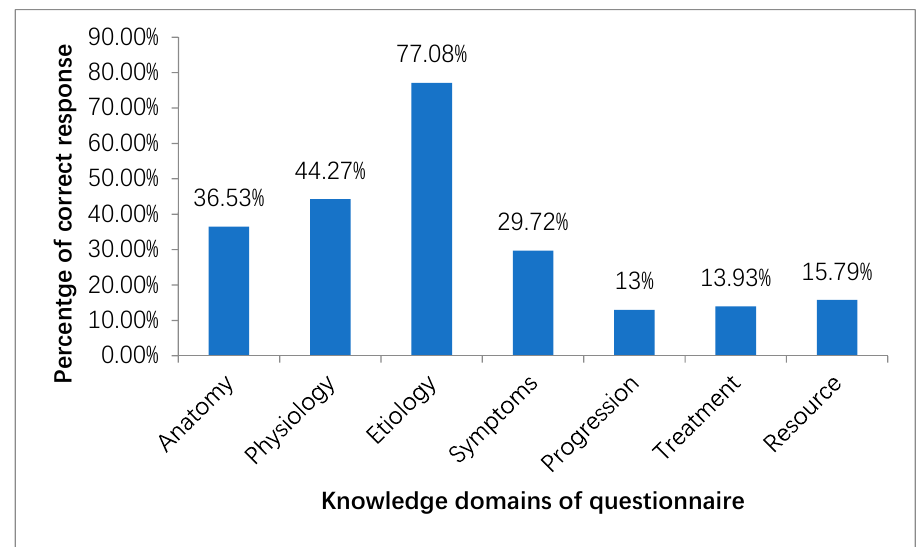
Figure 1. Percentage of patients with correct responses to the administered questionnaire.